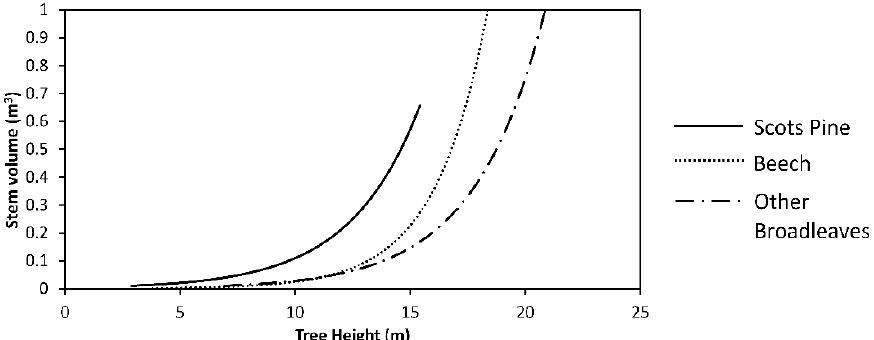
Figure 1. Three dendro-metric functions provided by [43] relating tree stem volume to tree height.